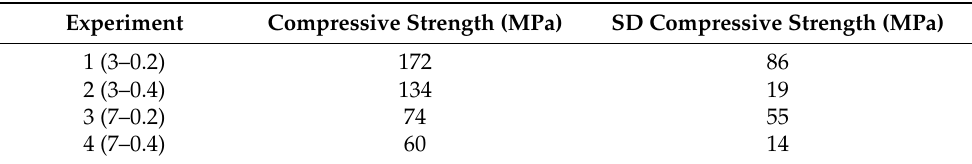
Table 5. Compressive strength of the YSZ